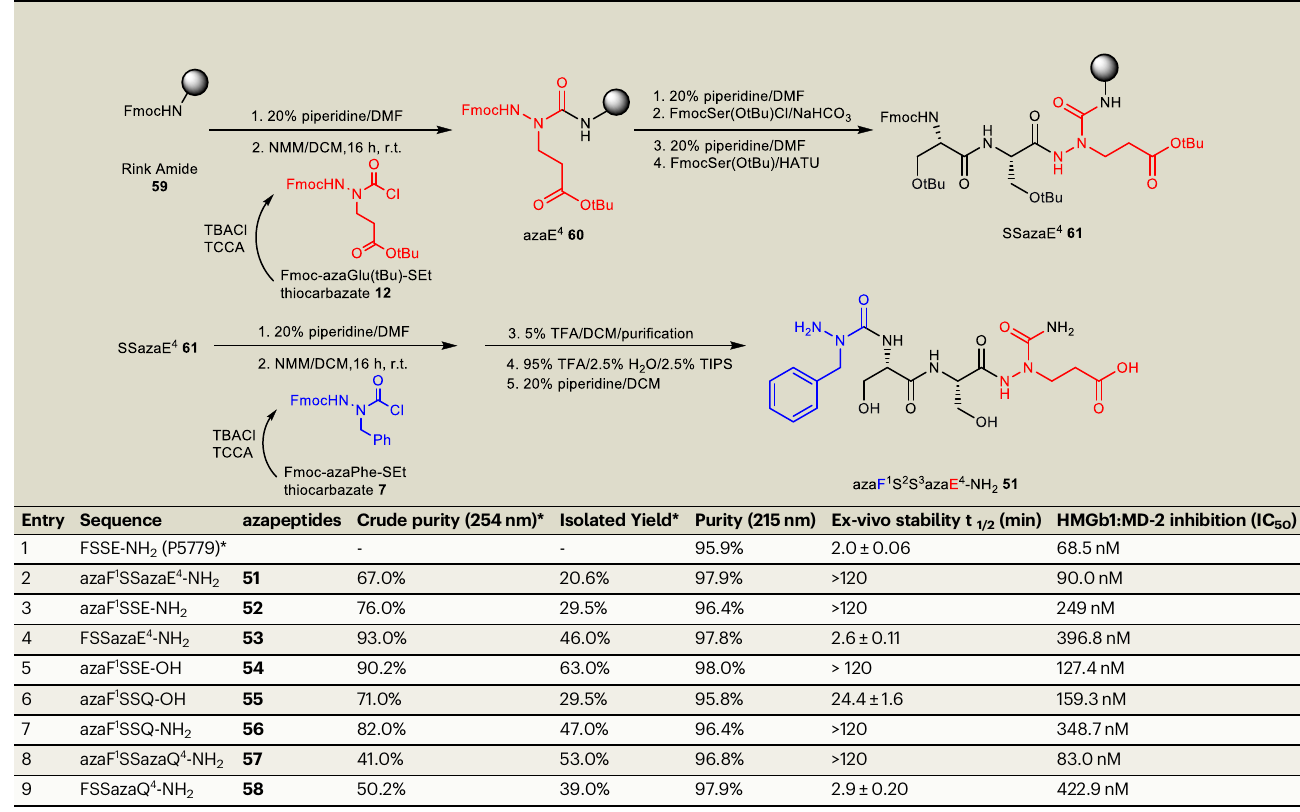
Table 3 | Summary of HMGB1/MD-2/TLR4 antagonist (FSSE) and FSSE azapeptide